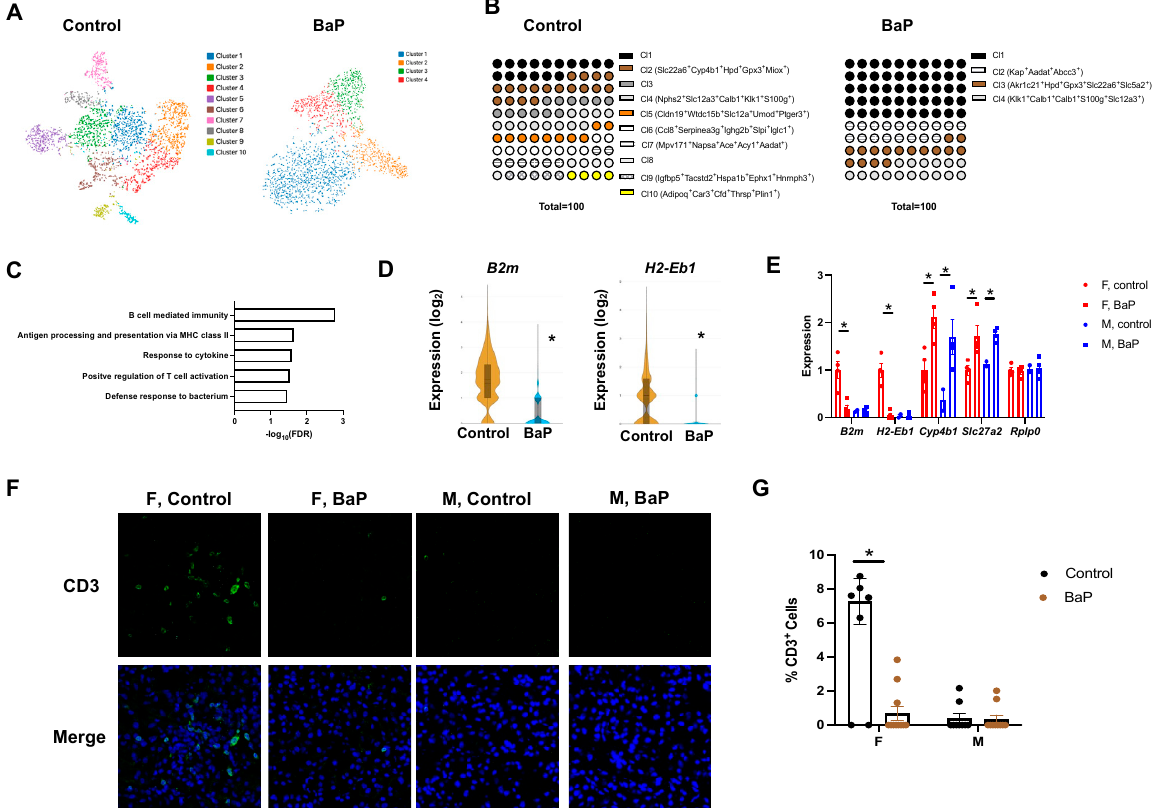
Figure 6. BaP treatment reduced cell-type diversity in the kidney of female MRL mice. ( A ) Cell clusters identified in the control- or BaP-treated kidney from female MRL mice, with their individual percentage shown in ( B ). ( C ) Top gene ontology categories enriched in genes downregulated by BaP treatment in the female MRL kidney, with example genes shown in ( D ). ( E ) Validation of BaP-regulated genes by qPCR. ( F ) Immunostaining of CD3 in female or male control- or BaP-treated kidney (10×), with quantification in ( G ). F, female. M, male. Control, vehicle-treated. BaP, BaP-treated. * p < 0.05, Student’s t -test.